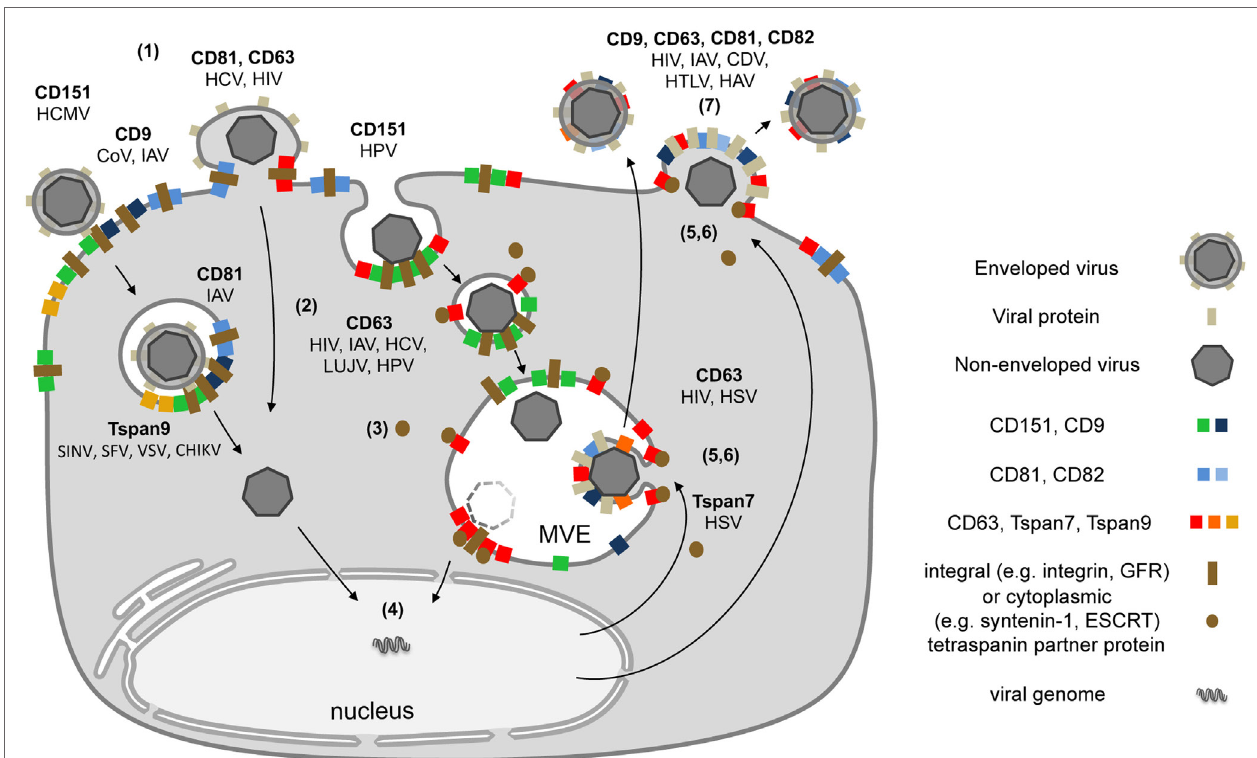
FigURe 2 | Schematic model depicting the subcellular localization of tetraspanins (Tspans) during virus infection. (1) Interactions between viral particles and entry receptors at Tspan clusters trigger the formation of larger cluster networks. (2) Tspan assemblies promote viral internalization by endocytosis and/or fusion. (3) Endocytosis is followed by intracellular trafficking of virus particles in transport vesicles. During this stage, Tspans mediate and organize interactions with cytoplasmic trafficking molecules. (4) These steps lead to delivery of viral genomes into the cytoplasm or the nucleus and successful infection. (5) Morphogenesis of enveloped viruses on Tspan-enriched microdomains. (6) Integration of viral proteins into Tspan clusters induces spatial enrichment of Tspans and viral proteins. (7) The resulting high concentration of virus envelope components enables efficient budding and